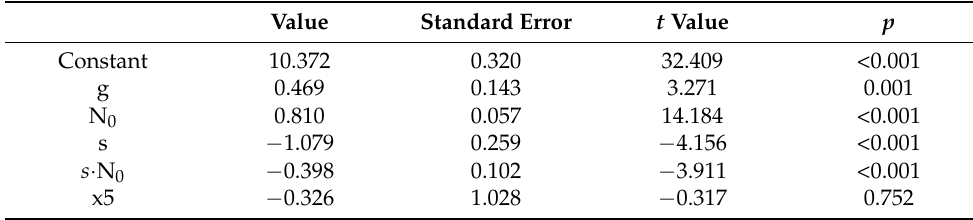
Table 2. Regression analysis predicting chronological age from the chosen